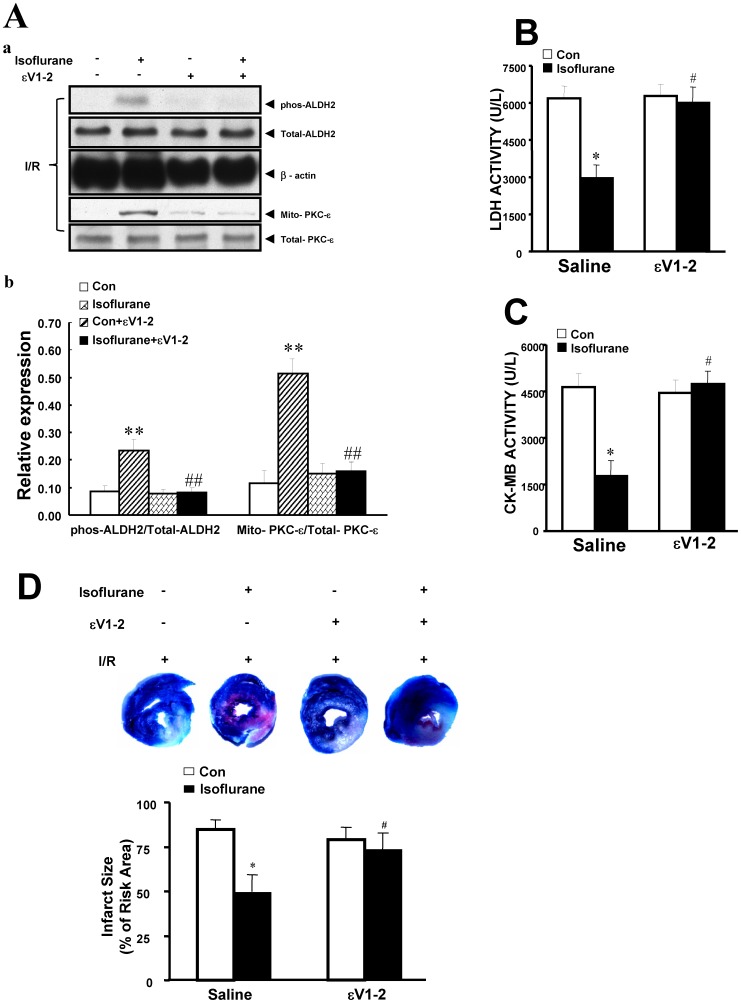
PKCε translocation is involved in isoflurane preconditioning.A PKCε translocation was associated with isoflurane-induced phosphorylation of ALDH2. (a) Representative of western blot analysis of phos-ALDH2, total ALDH2, β-actin, mitochondria PKCε (mito-PKCε) and total PKCε (from top lanes to bottom lanes). β-actin was used to demonstrate equal protein loading. (b) Quantification of the phos-ALDH2, normalized to the total ALDH2, and PKCε translocation to the mitochondria from 3 different experiments. B, C. Isoflurane-induced inhibition of LDH and CK-MB release by I/R was restored by PKCε v1–2. Serum LDH and CK-MB concentrations were analyzed. D. PKCε v1–2 inhibits the decrease in heart infarct size caused by isoflurane following I/R. Representative cross-sectional slices derived from a single heart. The infarct size normalized to the area at risk. Values are means ± S.E.M., n = 8 in each group. *P<0.05, **P<0.01 vs. the saline control group and #P<0.05, ##P<0.01 with PKCε v1–2 vs. the corresponding group without PKCε v1–2.